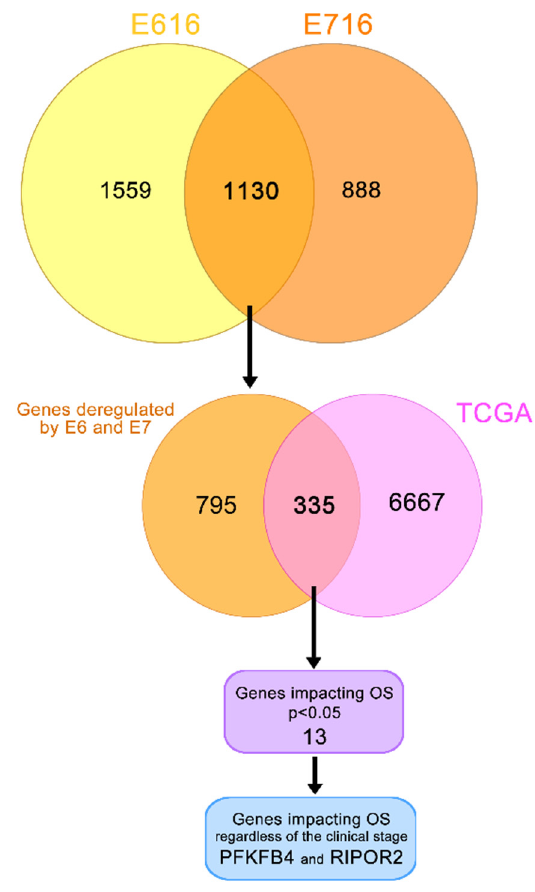
Figure 5. Genes deregulated in cervical cancer and in E6- and E7-expressing cells. Yellow/orange Venn diagram shows the genes deregulated by E616 and E716 in C-33 A stably transfected cells; the intersection of this diagram refers to the 1130 genes significantly modulated by both viral oncoproteins. Orange/pink Venn diagram intersects 335 genes modulated in CC according to the data obtained from TCGA and by the E6 and E7 viral oncoproteins. From these data, a univariate analysis showed 13 genes significantly affecting the OS ( p < 0.05). A multivariate analysis demonstrated that PFKFB4 and RIPOR2 genes affected the OS independently of the clinical stage ( p < 0.05).